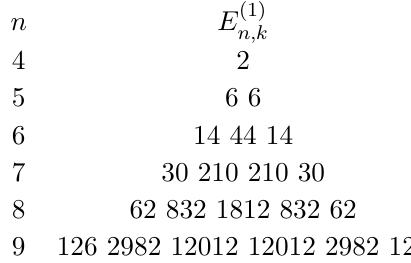
Figure 29 . Number of solutions to 1-loop scattering equations re(cid:12)ned by MHV degree in